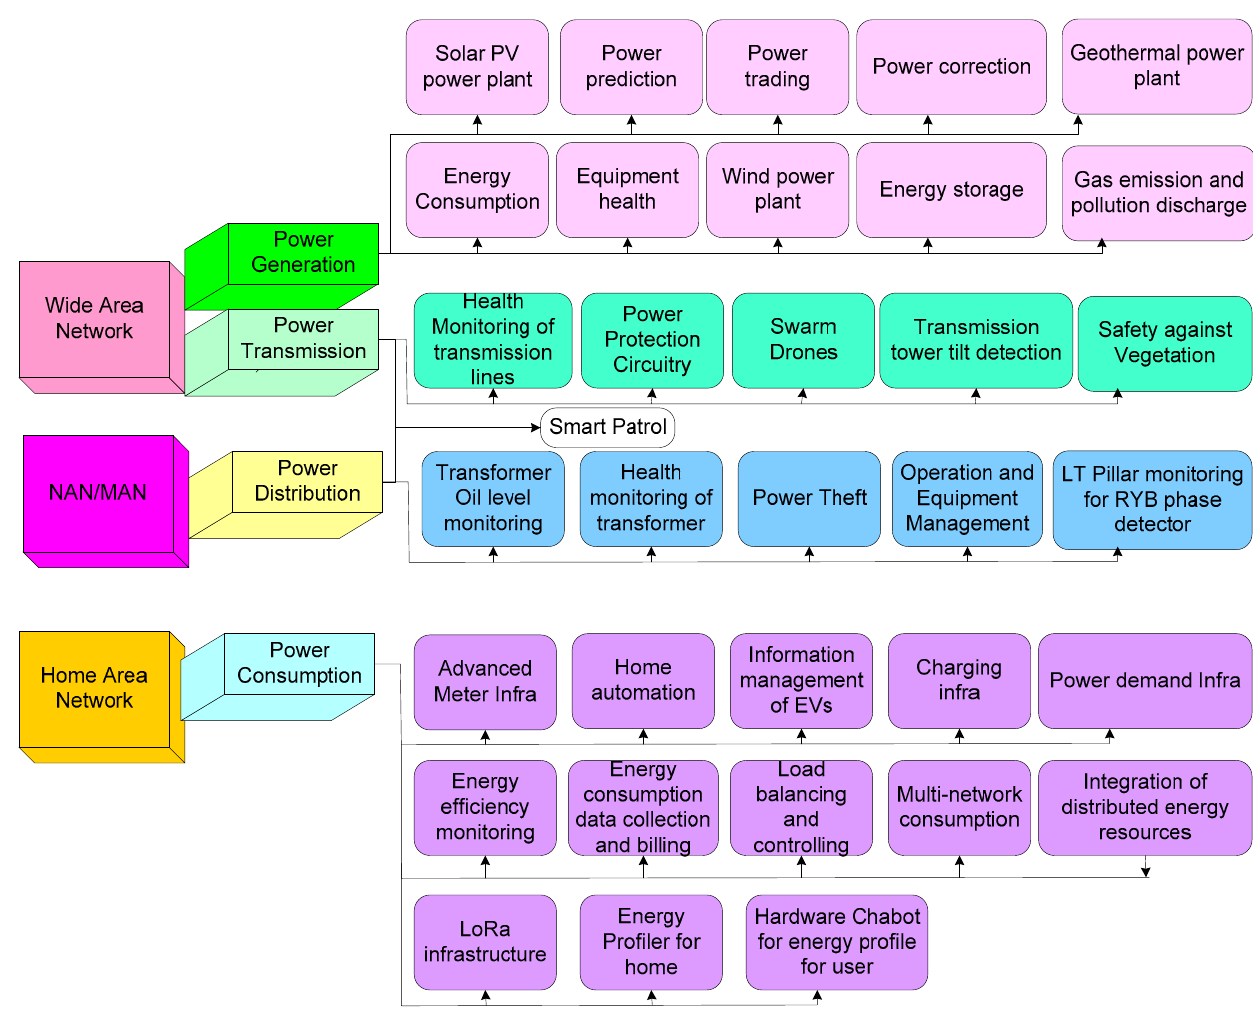
Figure 9. Potential application of IoT-enabled smart grid.